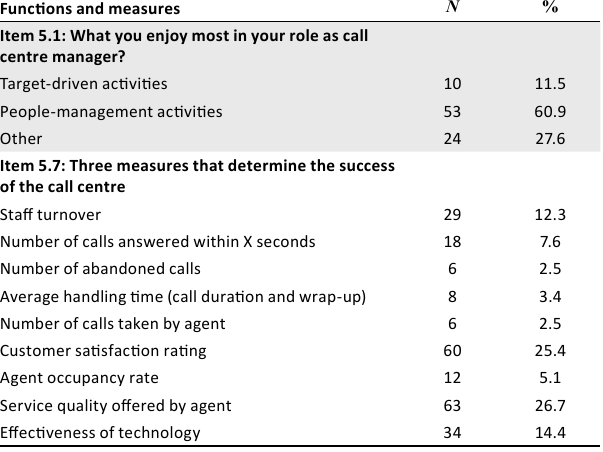
TABLE 12: Functions and measures that determine success that the managers enjoyed most. Functions and measures